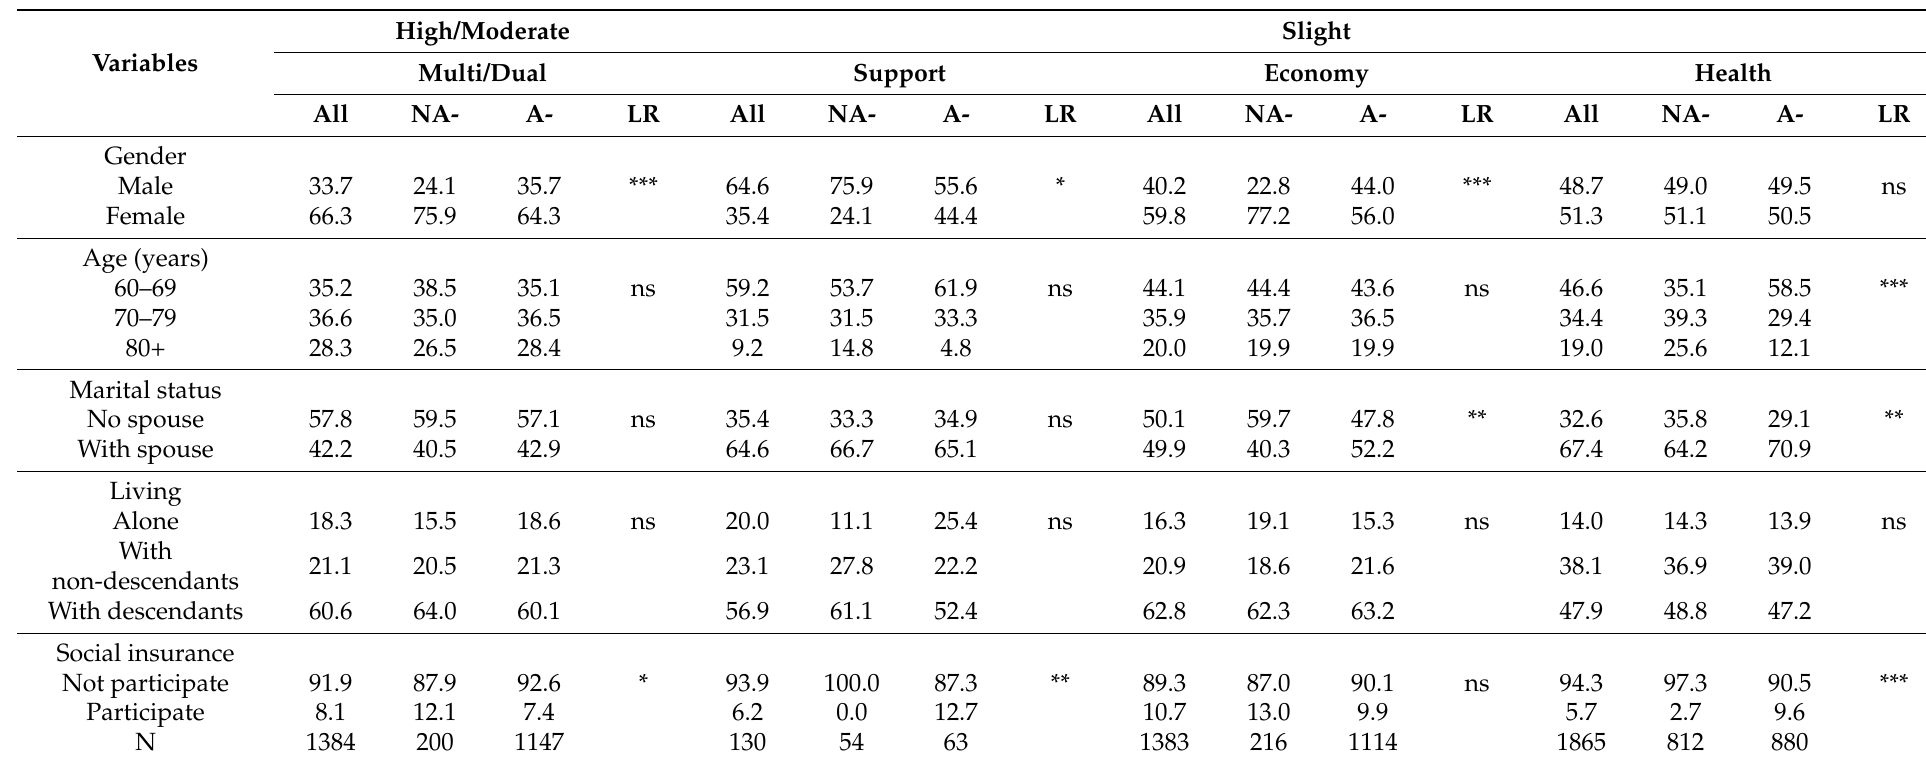
Table 8. Characteristics of different types of vulnerable older